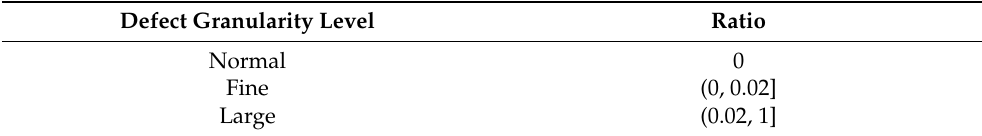
Table 2. Applied kernels of ResNet101 in